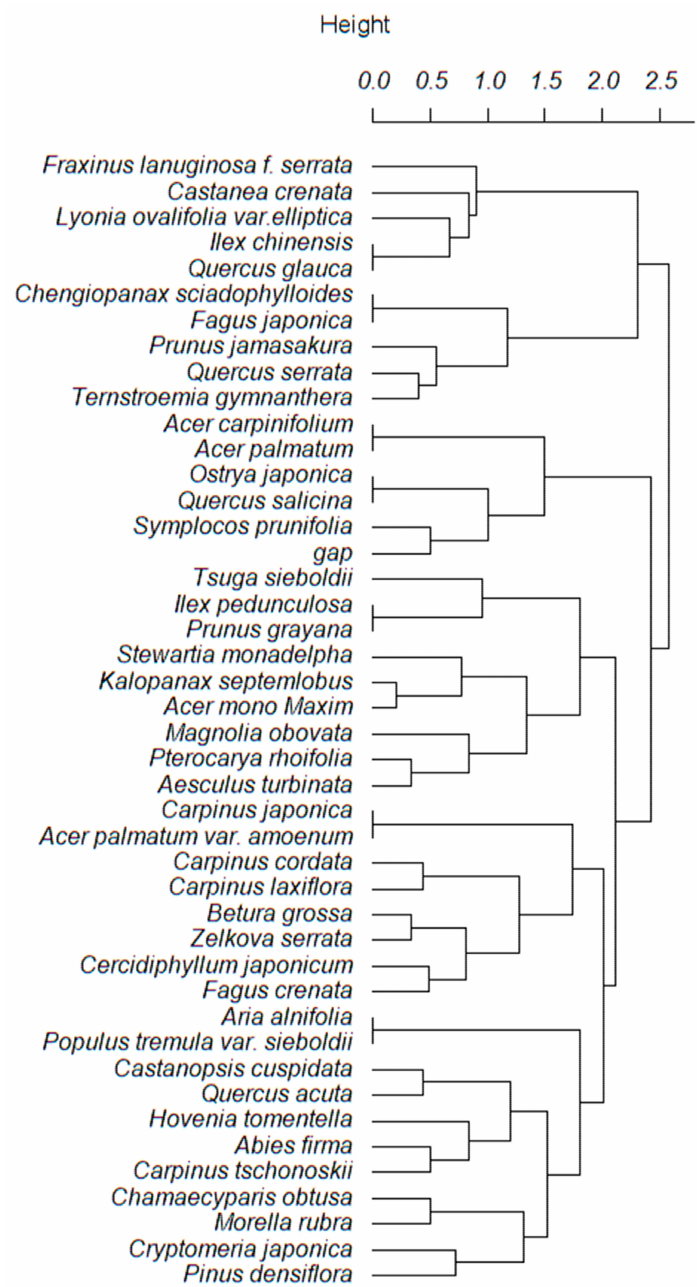
Figure 12. Similarities in appearance of trees species. This dendrogram was made from the distance calculated from F 1 score of each class in test classification